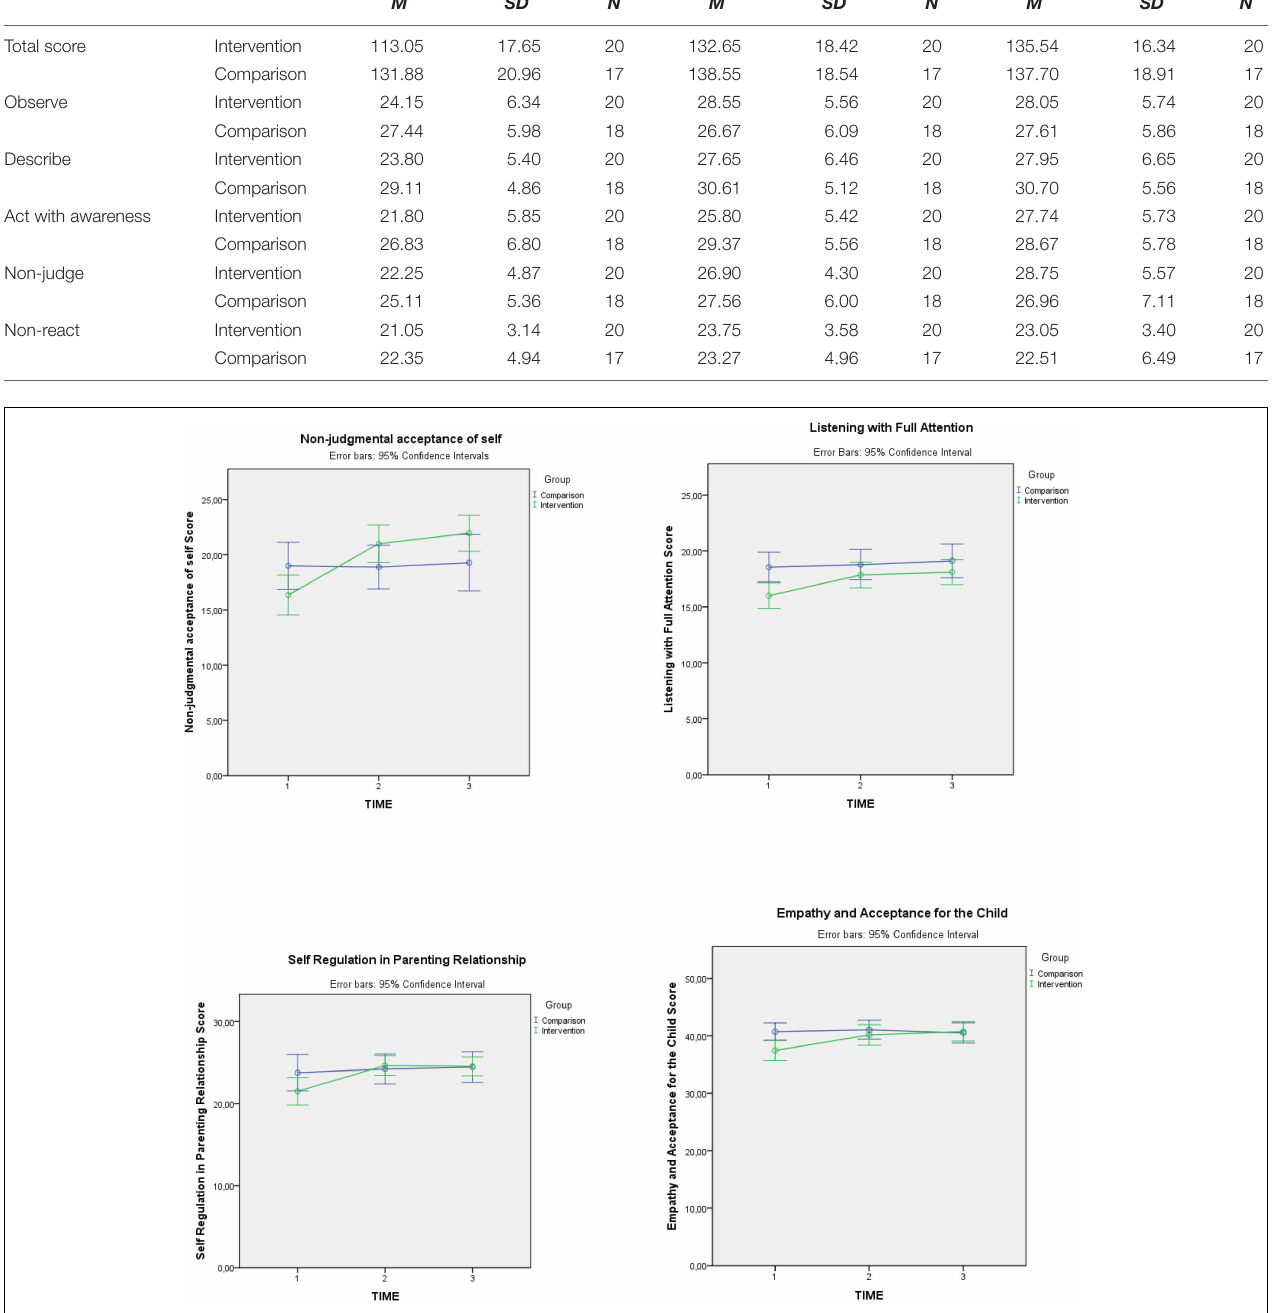
FIGURE 3 | IM-P subscales marginal pre, post, and follow-up